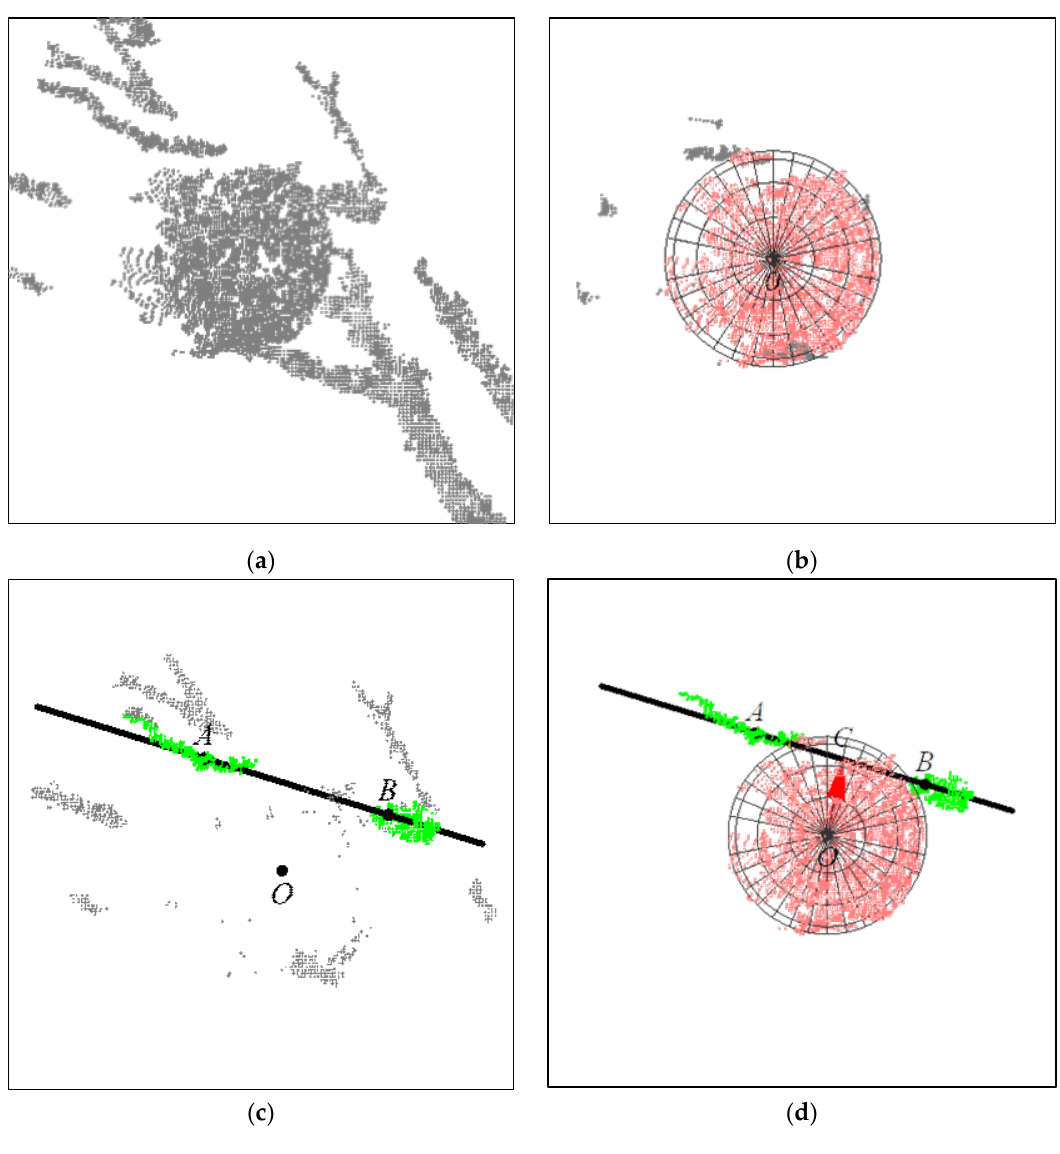
Figure 3. Pictures demonstrating the calculation process for apple-picking directions: ( a ) point cloud image of apple trees obtained by RGB-D camera; ( b ) fitting the fruit surface point cloud to a sphere; ( c ) fitting the point cloud on the surface of the nearest branch to the fruit to a straight line; ( d ) calculating the picking direction of the fruit based on the center of the fruit and the straight line of the branch.